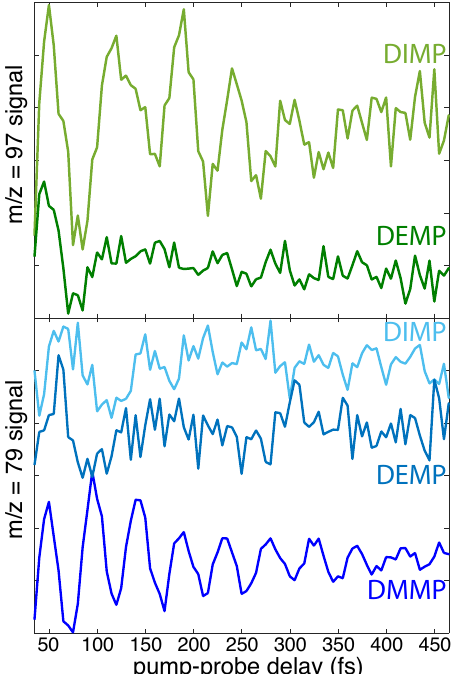
Figure 8. Oscillatory components of m / z = 97 ( top ) and m / z = 79 ( bottom ) signals in DMMP, DEMP, and